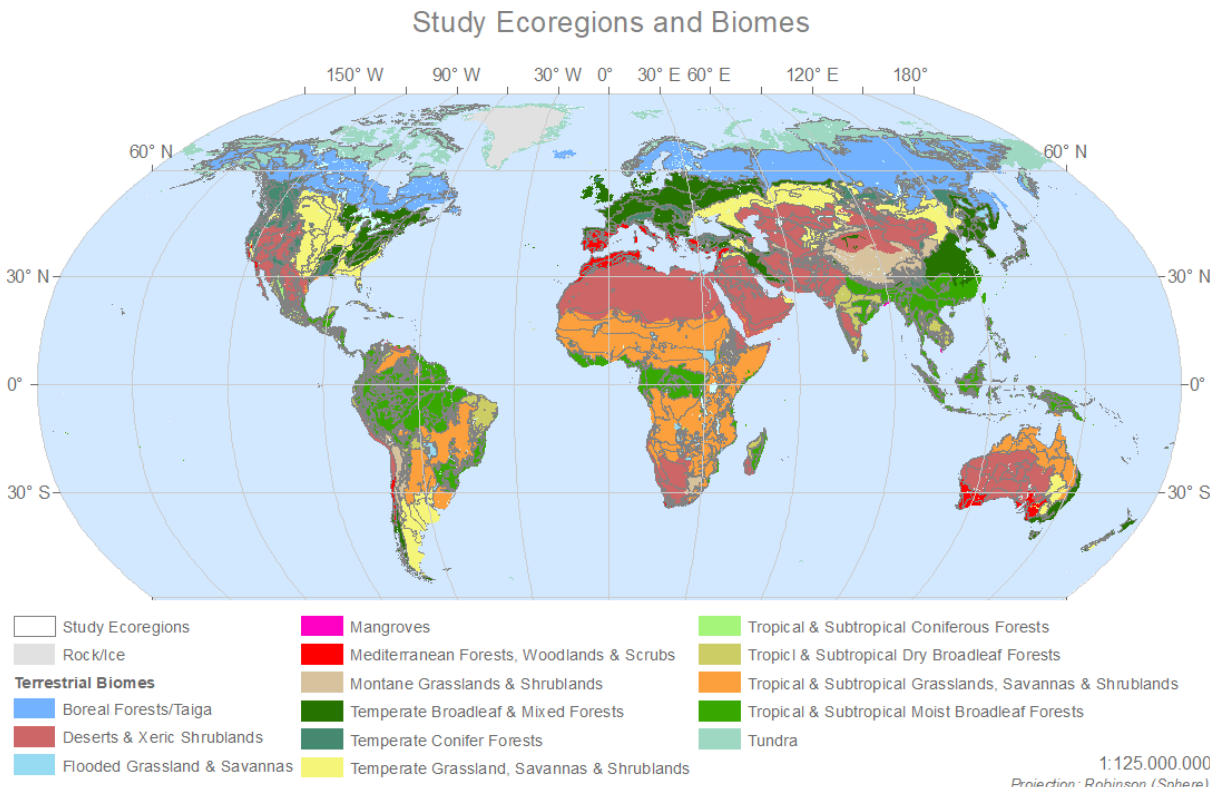
Figure A1. Terrestrial ecoregions within their respective biomes for this study (source: the authors).